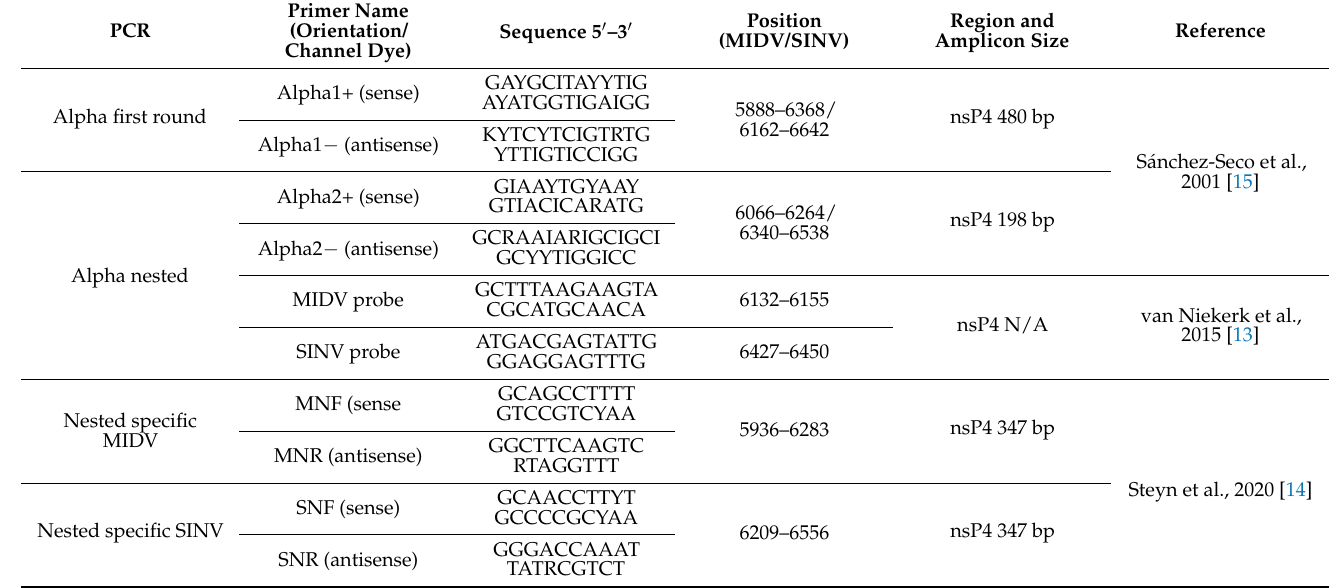
Table 1. Primers and probes used for detection of alphaviruses targeting a conserved region of the nsP4 gene in alphaviruses and the E1 region of MIDV specifically. Nucleotide positions are indicated for MIDV (Genbank accession number KF680222.1) and SINV (Genbank accession number U38305)